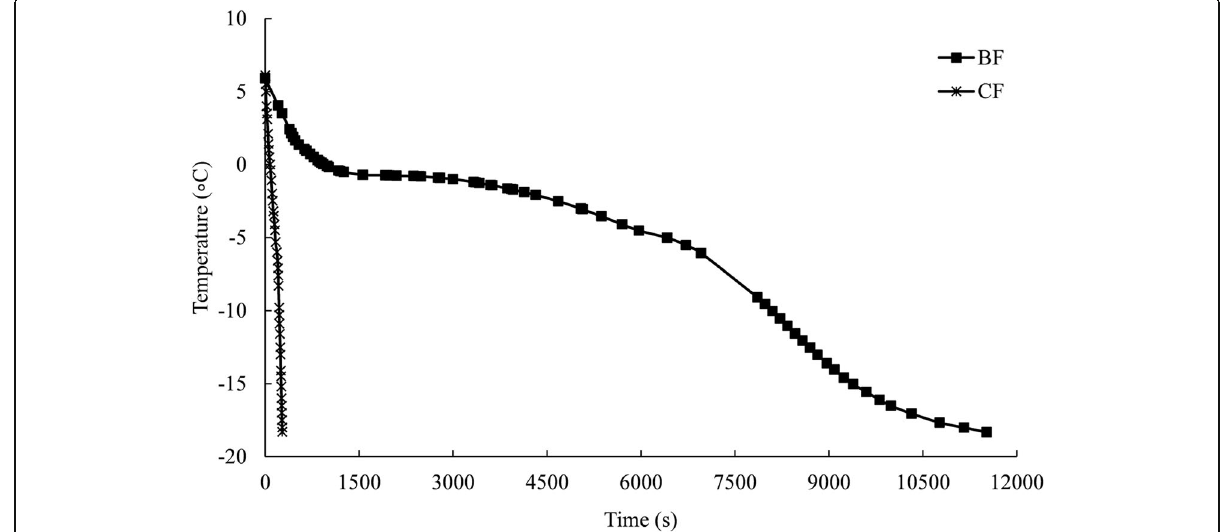
Fig. 2 Freezing curves of crawfish minced meat. CF = cryogenic freezing and BF = air blast